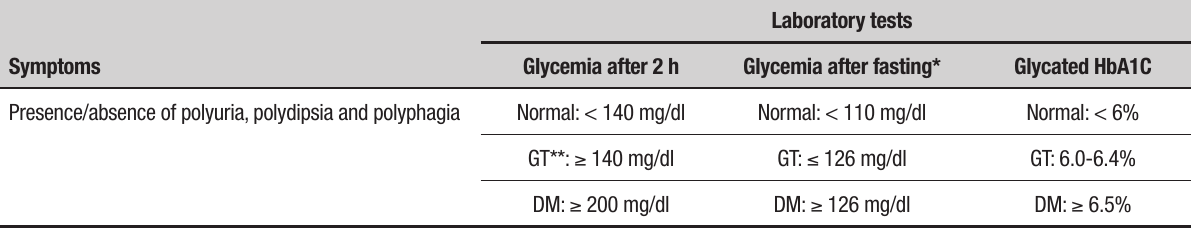
Laboratory tests